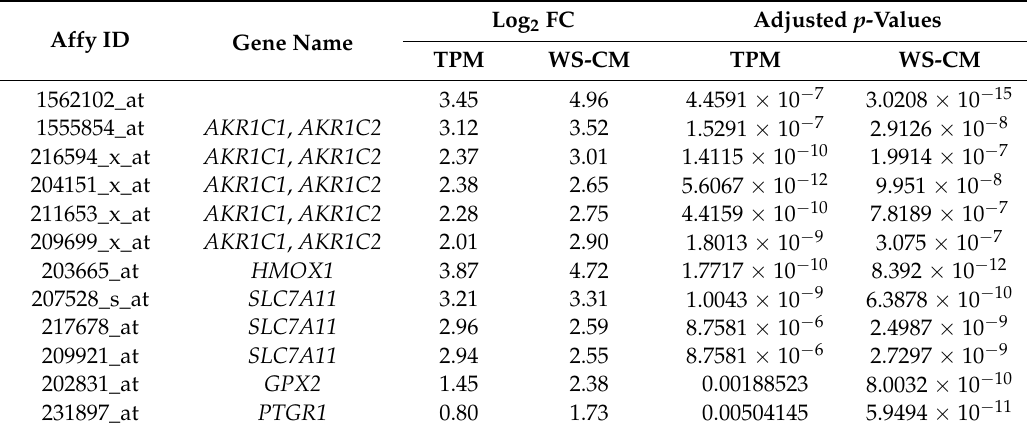
Table 2. Six common genes that are robustly upregulated by total particulate (TPM) and whole-smoke conditioned media (WS-CM) in all 3 cell